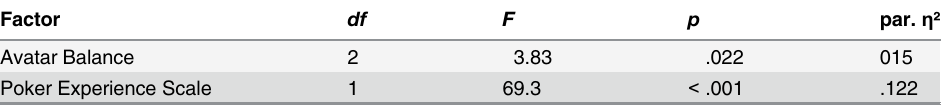
referring to the number of female and/or male opponents (avatars) at the virtual online poker table: 1) gender mixed (two female and two male), 2) all male, and 3) all female